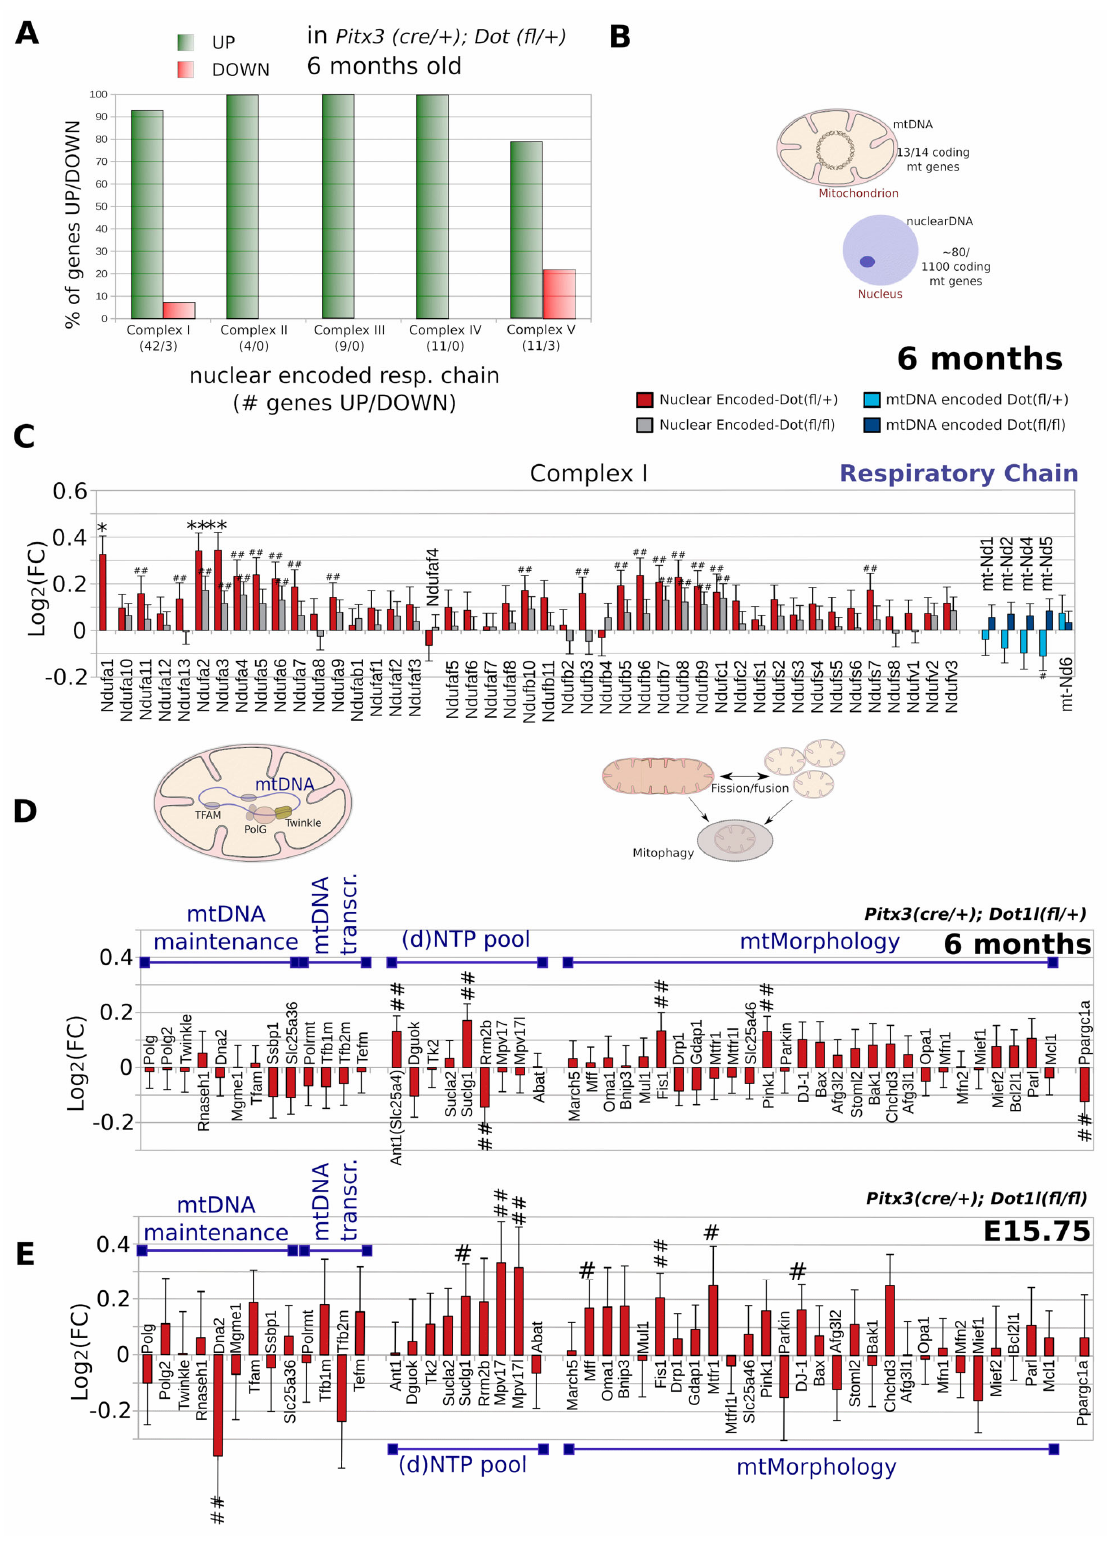
Figure 6. Majority of respiratory chain genes, Pink1 , Fission , and DJ-1 show upward trend following Dot1l reduction. ( A ) Ratio of genes up- versus down-regulated in heterozygous Dot1l floxed DA neurons. ( B ) Schematic overview of mitochondrial and nuclear DNA, indicating an approximation of the number of (encoding) mitochondrial genes located at the mtDNA and nuclear DNA. Respiratory chain genes are encoded both at the mtDNA (13 out 14 encoding genes) as well as the nucleus (~80/1100 mitochondrial genes). ( C ) All retrieved complex I respiratory chain genes of